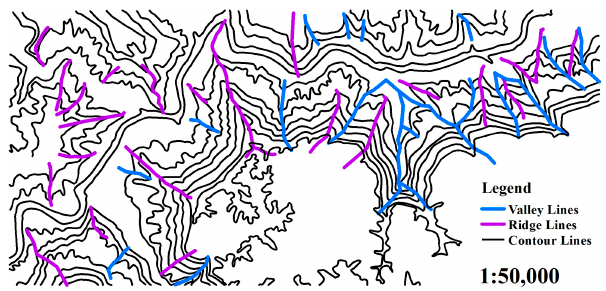
Figure 19. Terrain features in the terrain map of 1:50,000.